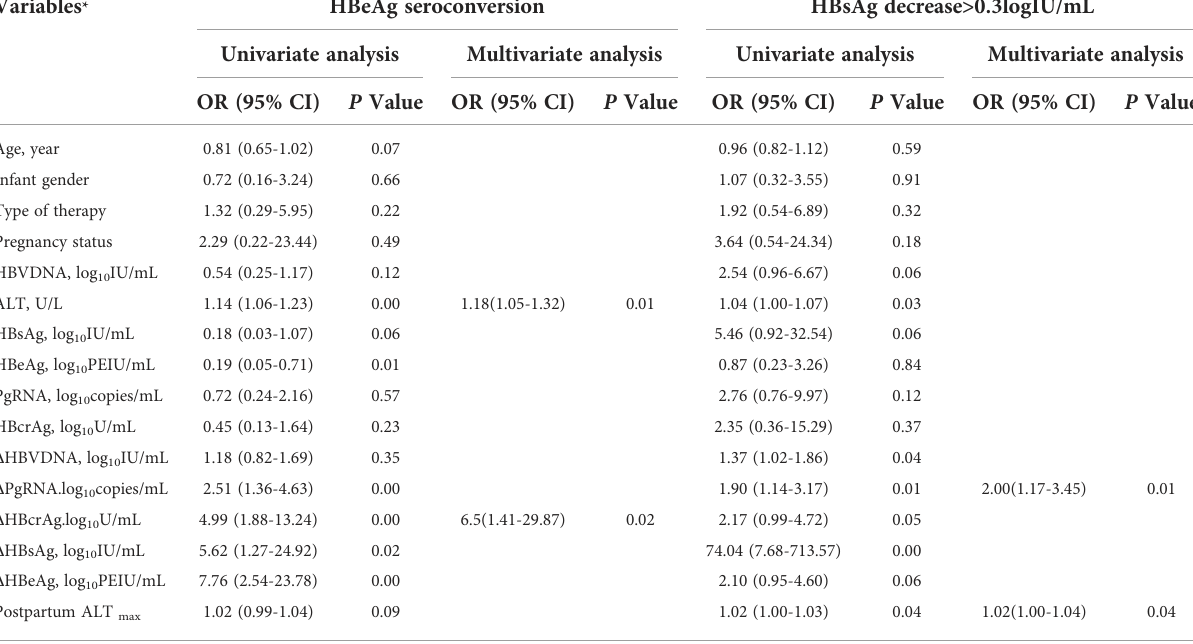
TABLE 2 Logistic regression analysis for factors of HBeAg seroconversion and HBsAg reduction postpartum in HBeAg positive carriers (N=76).